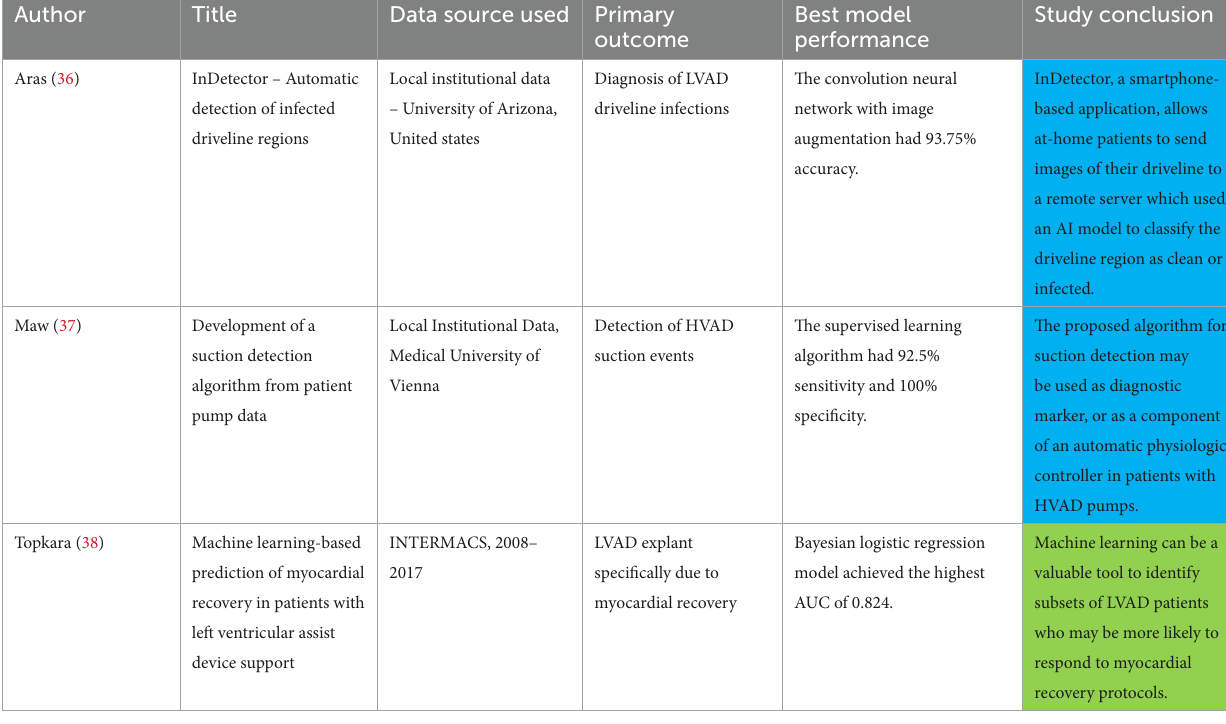
TABLE 4 Summary of publications describing artificial intelligence application in guiding mechanical circulatory support